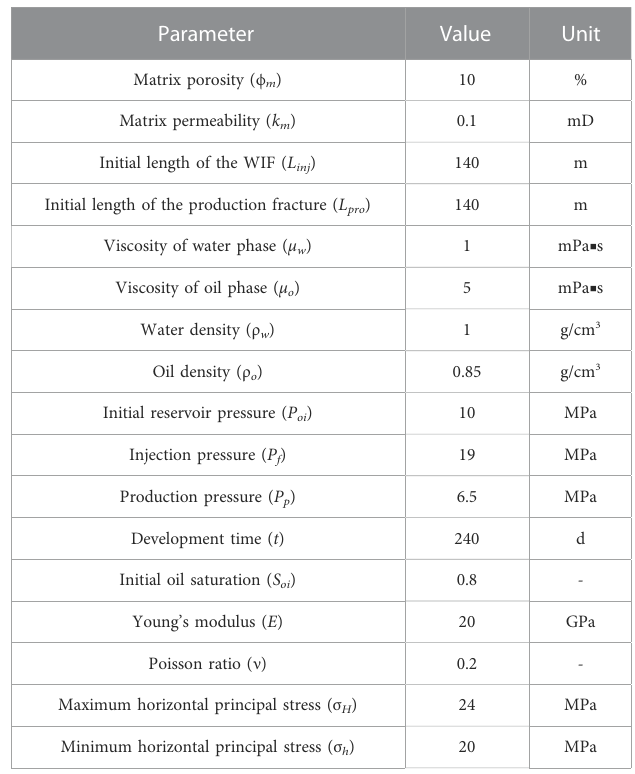
TABLE 1 Basic parameters for the cases of numerical simulation.